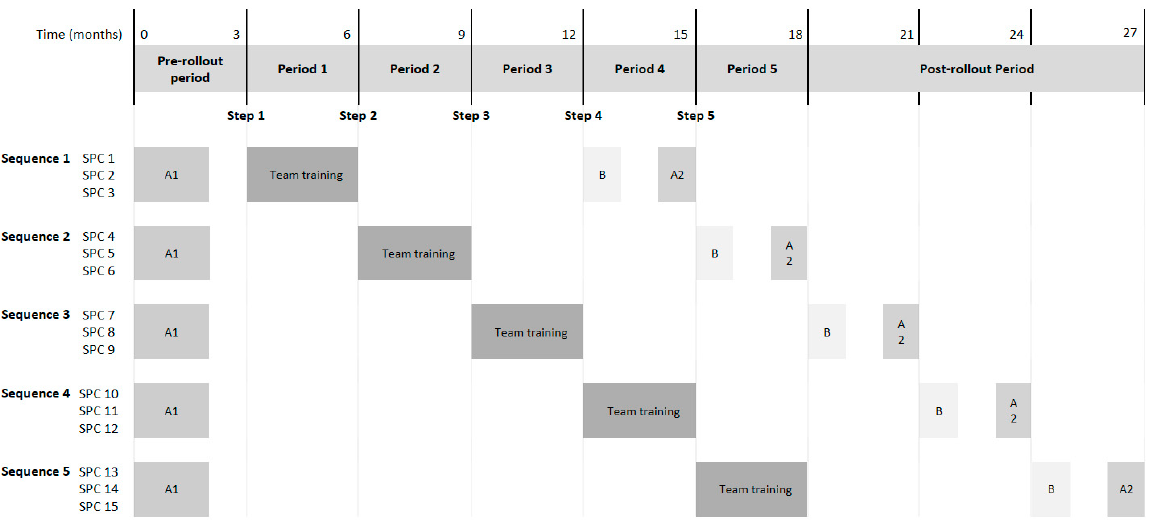
Figure 5. Overview of the process evaluation. We conduct baseline (A1) and follow-up surveys (A2) and semi-structured telephone interviews (B) with SPC directors and staff. SPC, social paediatric centre.